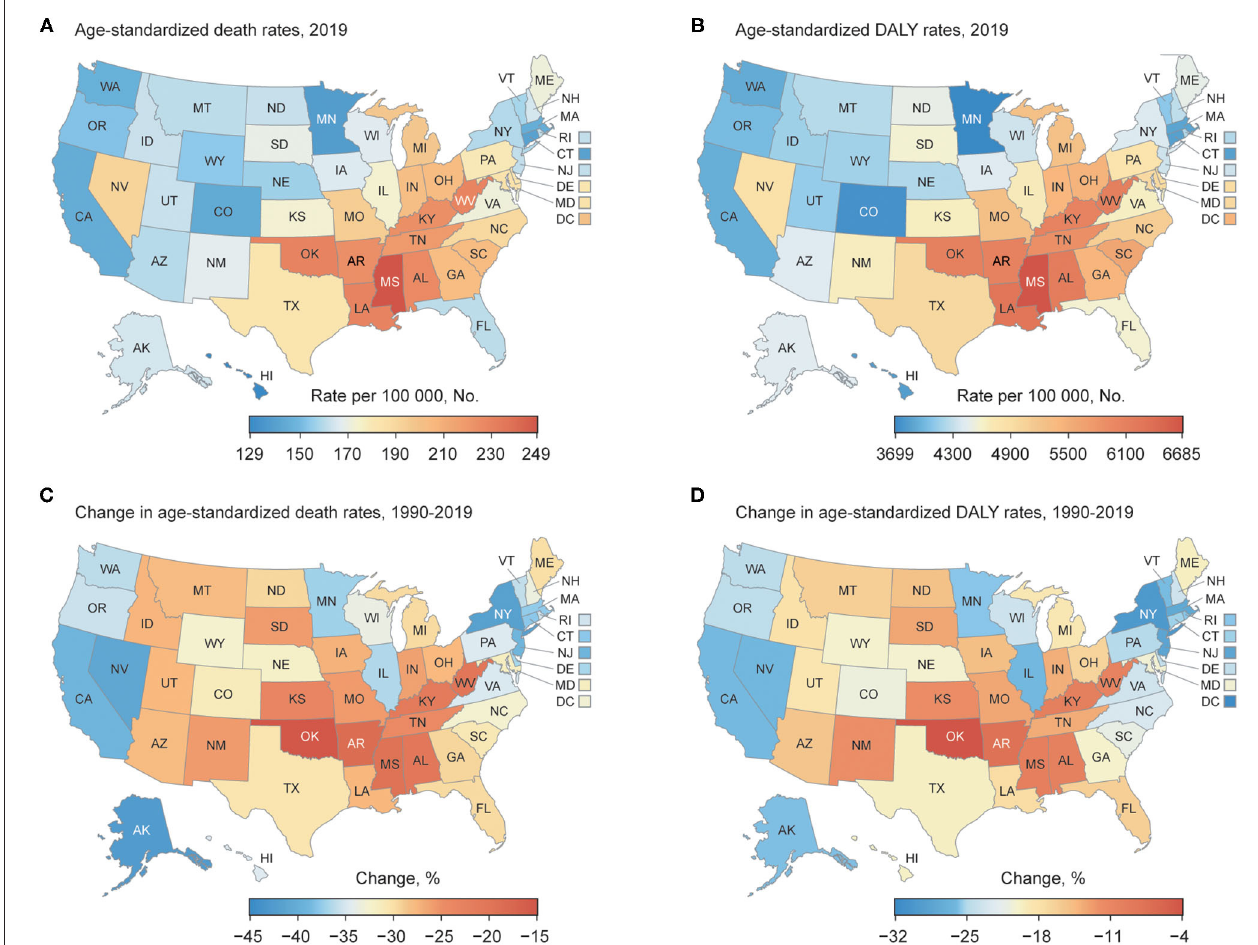
FIGURE 3 | Burden attributable to metabolic risk factors for each state in the US: ( A) Age-standardized death rate attributable to metabolic risk factors in 2019; (B) Age-standardized DALY rate of RIT in 2019; (C) Change in age-standardized death rates attributable to metabolic risk factors, 1990–2019; (D) Change in age-standardized DALY rates attributable to metabolic risk factors,